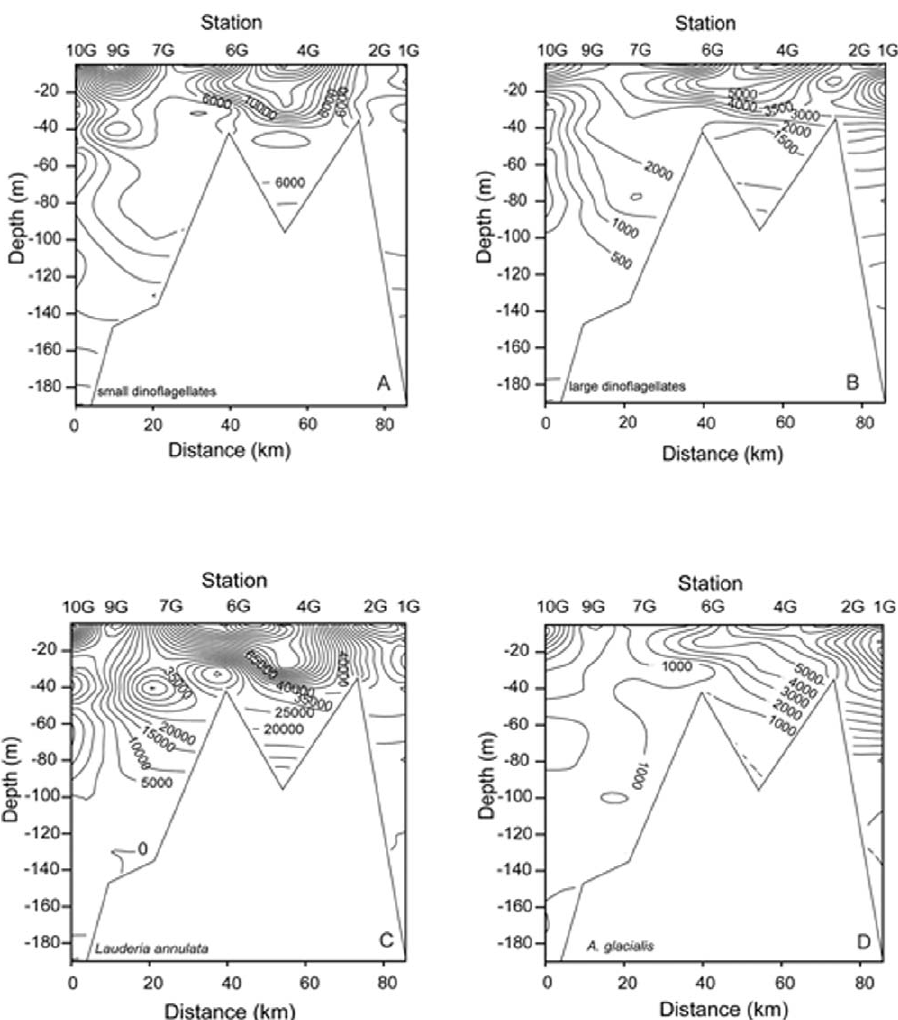
Figure 8. Contour plot of Lauderiaannulata and Asterionellopsisglacialis on shelf. Vertical and horizontal distribution [cells L 2 1 ] of (a) dinoflagellates , 20 m m. (b) dinoflagellates . 20 m m, (c) Lauderia annulata and (d) Asterionellopsis glacialis , at the shelf stations (10G to 1G).